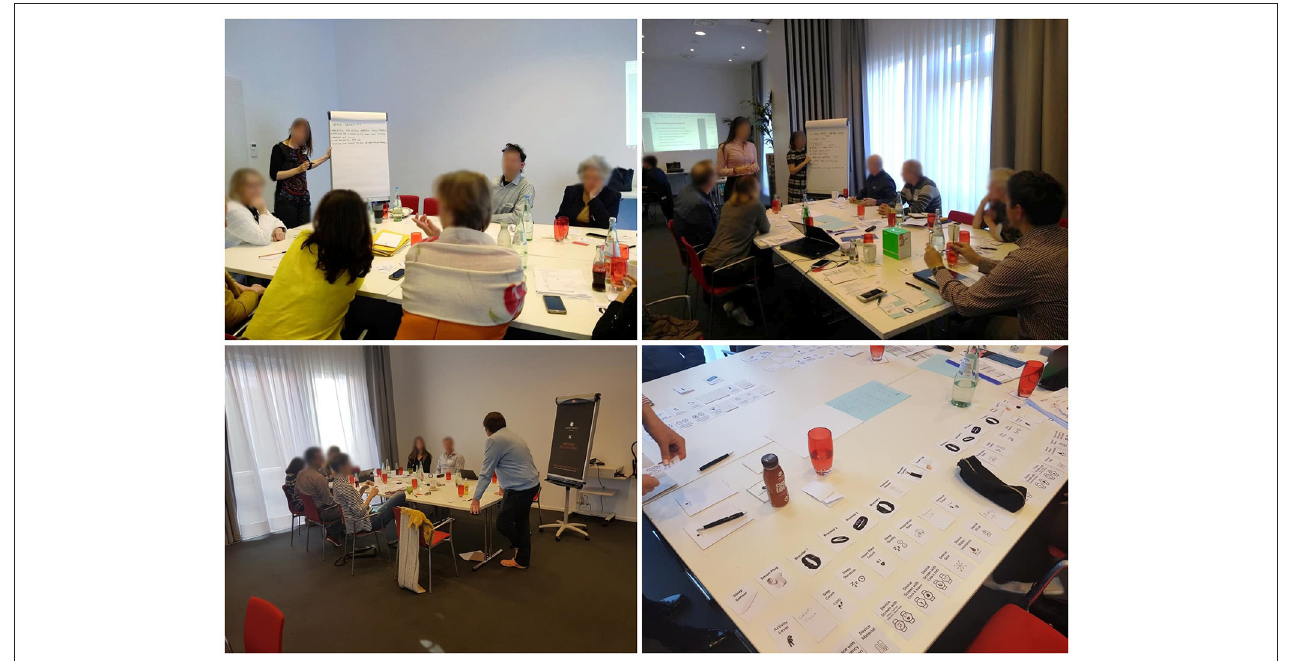
FIGURE 3 | The setting, the three groups—round tables and materials used during the PAB Session.